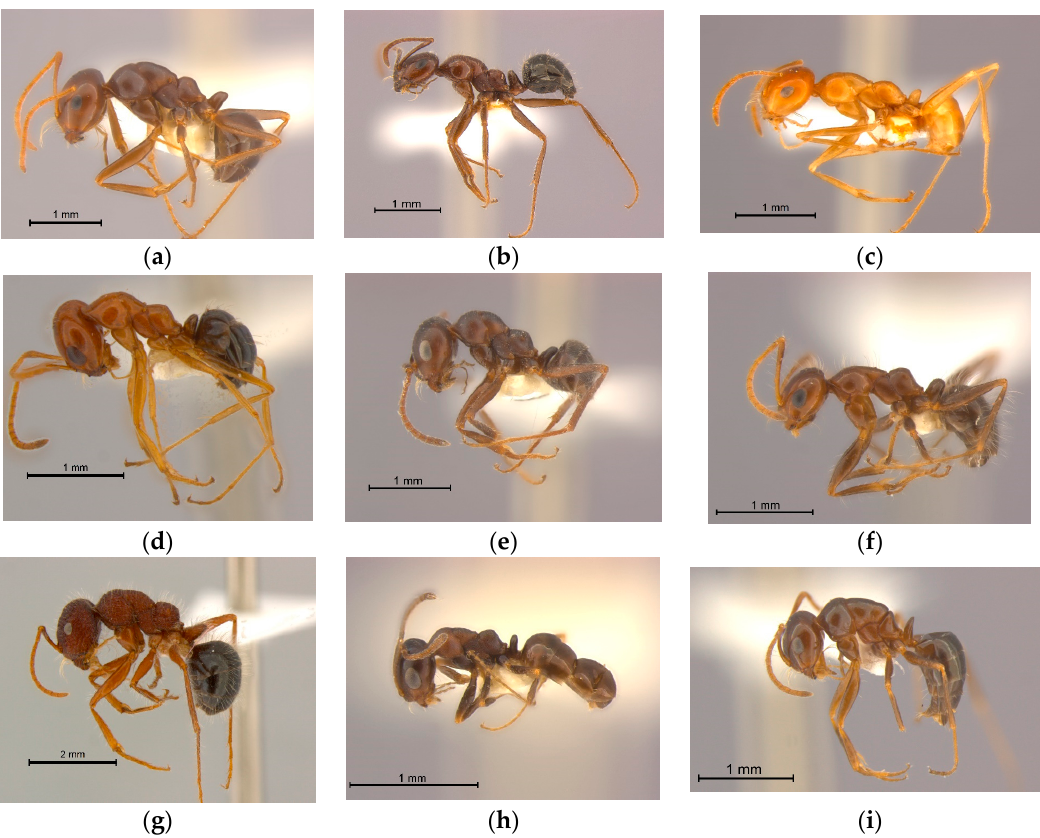
Figure 7. Representatives of the M. fieldi radiation. ( a ) Member of the M. perthensis group; ( b ) member of Melophorus Group J; ( c ) member of the M. fieldi group; ( d ) member of the M. turneri group; ( e ) member of the M. bruneus group; ( f ) member of the M. pillipes group; ( g ) member of Melophorus Group E; ( h ) member of Melophorus Group M; and ( i ) member of Melophorus Group N. The CO1 tree revealed six cases where specimens sorted as two morphospecies are likely to be conspecific: sp. O (specimen 195) and GWW sp. Y (889 and 890) within the M. turneri gp.; GWW sp. CE (949) and GWW sp. BC (257) within the M. fieldi gp.; GWW sp. C (256) and sp. Eurardy 25 (259) within the M. fieldi gp.; NATT sp. AN (573) and NATT sp. AF (572) within Group A; sp. P (612) and sp. TREND AO (615) within Group B; and Eurardy sp. BB (074, 075) and Eurardy sp. M (076 and 077)